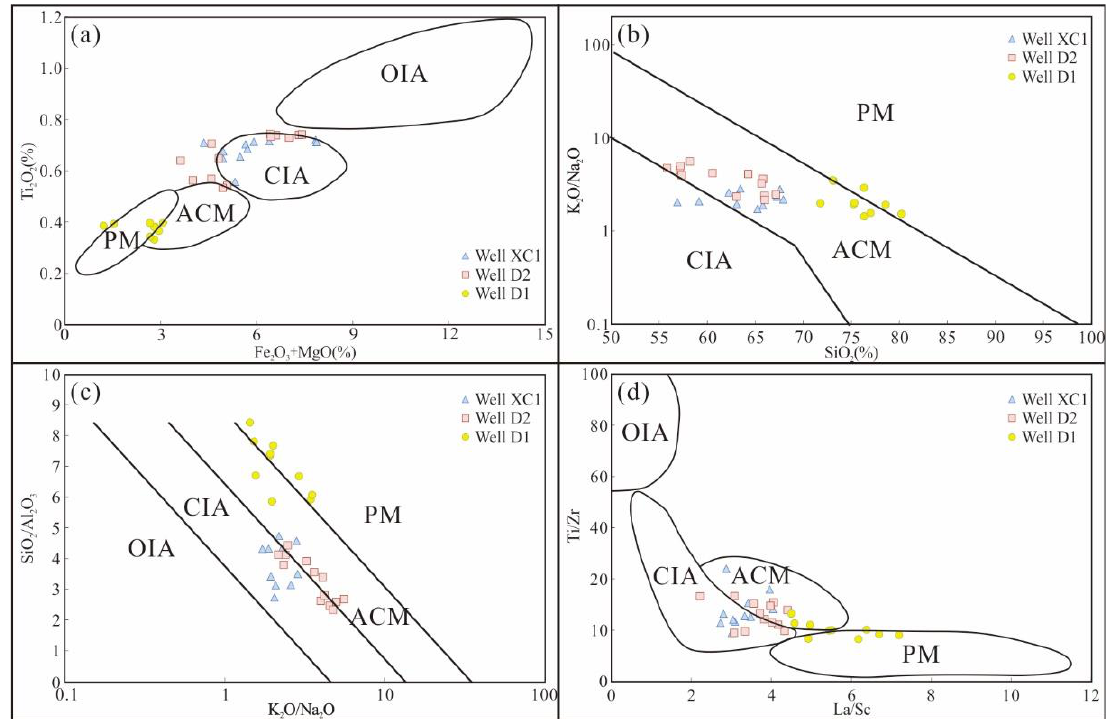
Figure 7. Tectonic setting discrimination diagram of the provenance area from Wudun sag. ( a ) TiO 2 −(Fe 2 O 3 + MgO) plot; ( b ) K 2 O/Na 2 O−SiO 2 plot; ( c ) SiO 2 /Al 2 O 3 −K 2 O/Na 2 O plot; ( d ) Ti/Zr−La/Sc plot. (PM-Passive continental margin, ACM-Active continental margin, CIA-Continental island arc, OIA-Oceanic island arc)